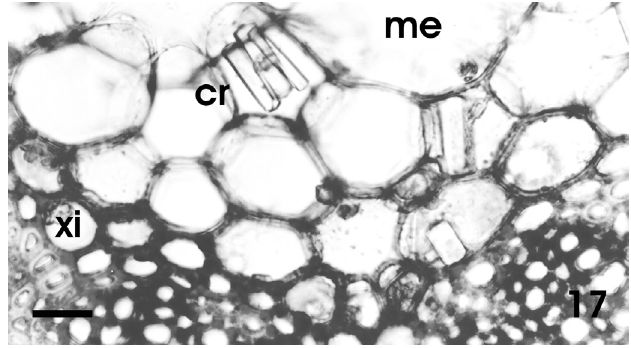
FIGURA 17 – B. trimera – Detalhe da região perimedular, em secção transversal. cr: cristais de oxalato de cálcio prismáticos de diferentes dimensões; me: medula; xi: xilema. Barra = 20 µ